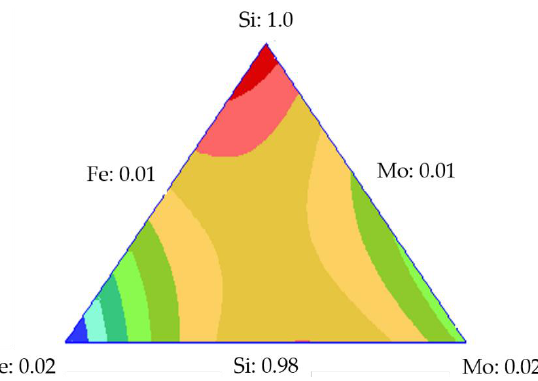
Figure 10. Response surface of adsorption for the mixture design of Si-Fe-Mo at 100 mg·L −1.